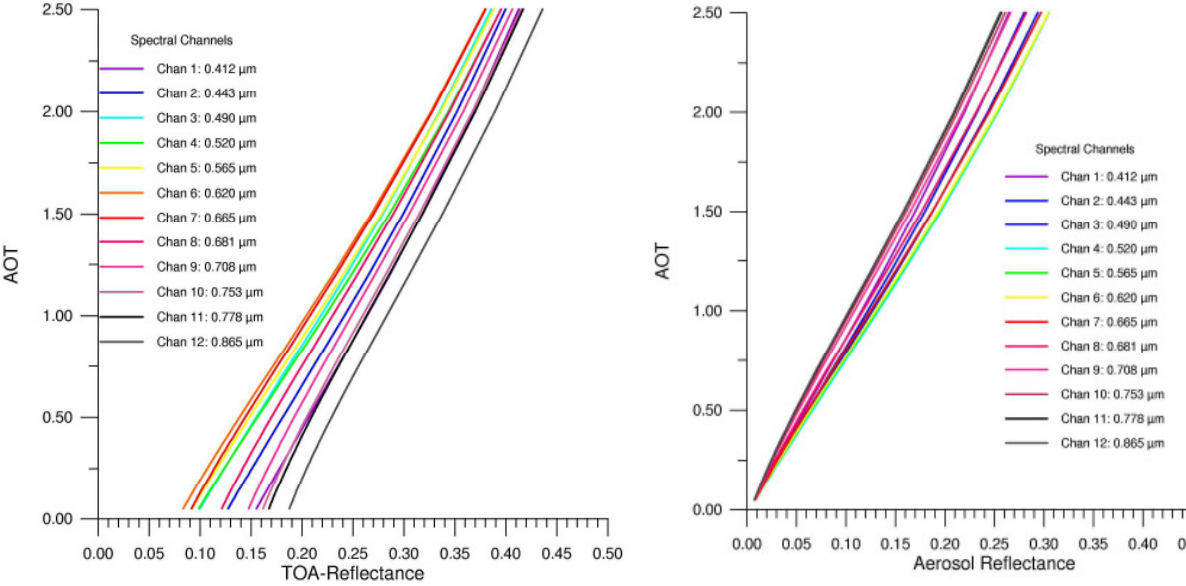
Fig. 6. Examples of spectral look-up-tables to convert (a) left: TOA reflectance to AOT and (b) right: aerosol reflectance into AOT for the main MERIS channels for one given illumination – viewing configuration ( z 0 = 38 ◦ , z S = 23 ◦ , φ = 68 ◦ ). The example shows results for LUT No. 6 – experimental phase function of LACE-98 and non absorbing aerosol.